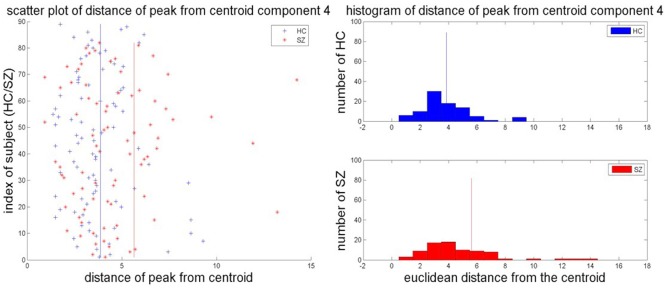
Scatter plot and group histograms of DPC. The group mean DPC is represented as red and blue lines for SZ and HC, respectively.